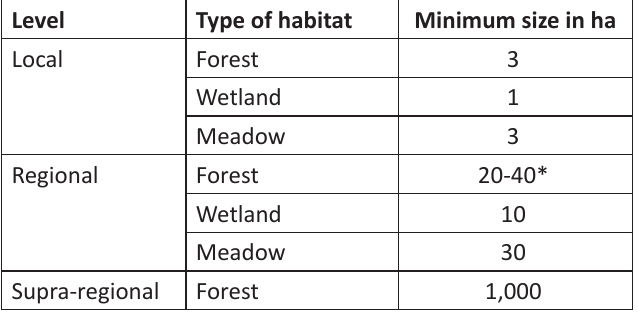
* Depending on vegetation zone and type of biogeographic unit/biochore, which depicts a unique combination of landscape potential and actual habitat (Culek et al.